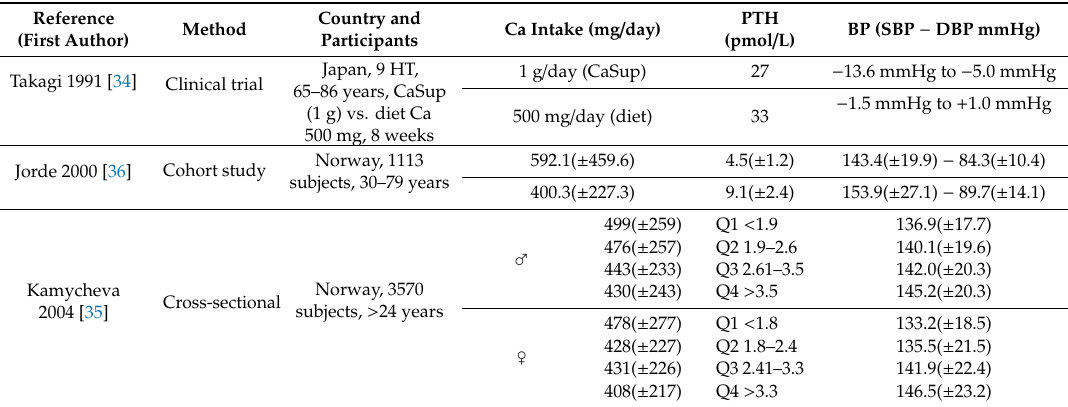
Table 3. Parathyroid hormone (PTH) and blood pressure (BP) and dietary calcium intake in human